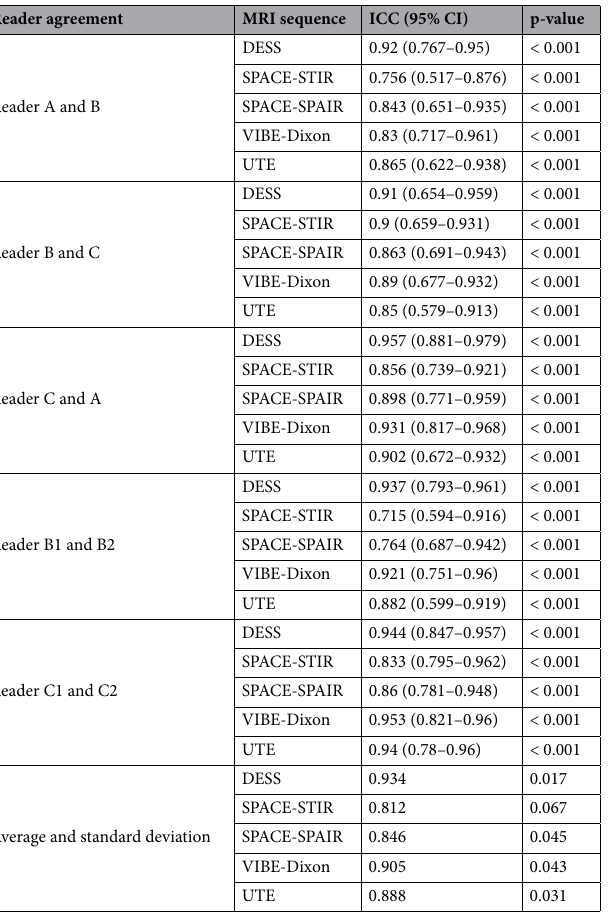
Table 2. Qualitative assessment of OPG (orthopantomogram) MRI reconstructions (MR-OPG) from the 3D double-echo steady-state (DESS), 3D fast spin echo short-tau inversion recovery (SPACE-STIR), 3D fast spin echo spectral attenuated inversion recovery (SPACE-SPAIR), 3D volumetric interpolated breath-hold examination (T1-VIBE-Dixon), and 3D ultrashort echo time (UTE) datasets were evaluated in randomized order by three readers with varying degrees of experience (reader A, attending board-certified oral surgeon; reader B, resident oral surgeon; reader C, attending board-certified radiologist and neuroradiologist). Intra- and inter-reader agreement was evaluated by Intraclass Correlation Coefficient (ICC): type 2:1 and the 95% Confidence Interval (CI) based on absolute agreement 2-way random model. Corresponding p-values are